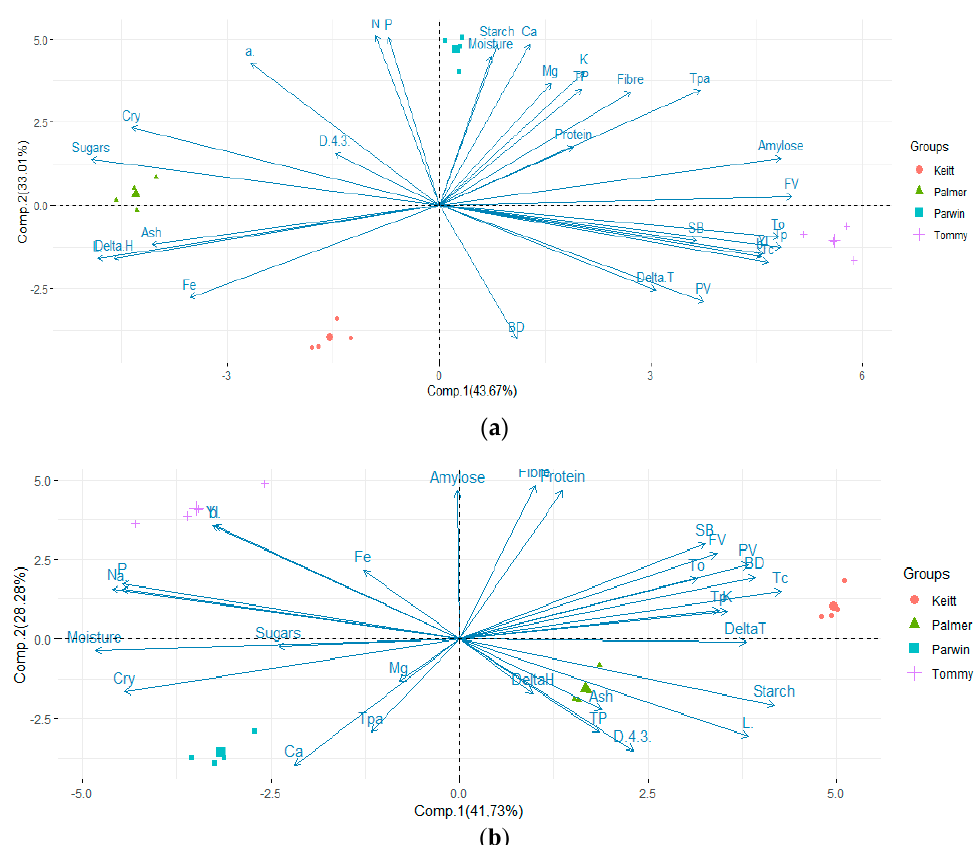
Figure 5. Biplot of principal component analysis. Pulp starches ( a ) and kernel starches ( b ).